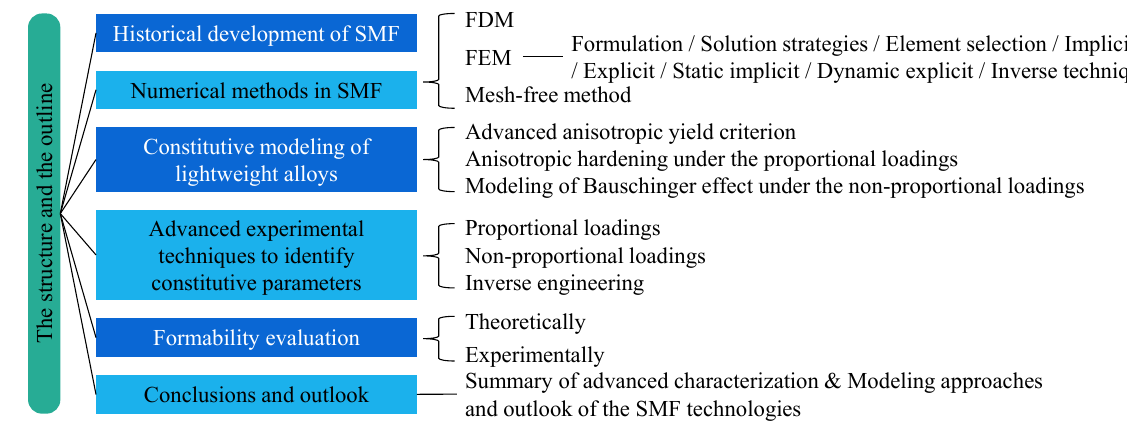
Figure 8. The structure of the current review.